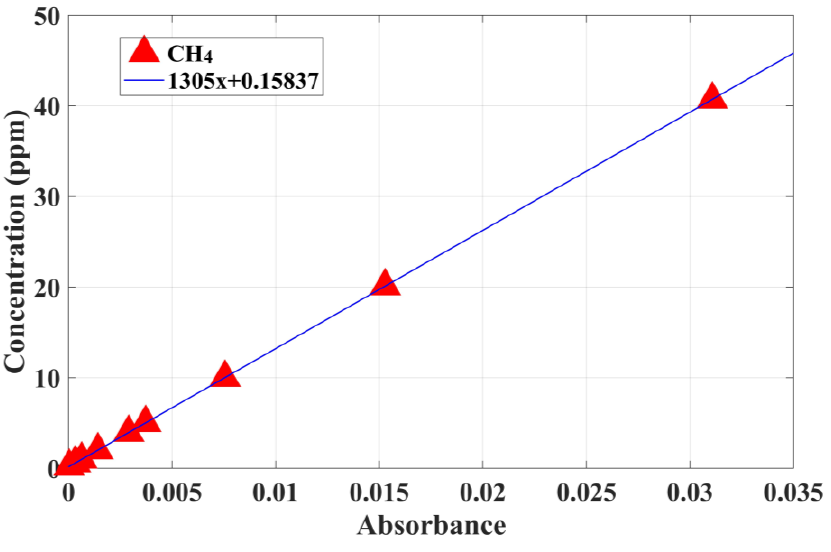
Figure 8. The fitting result in the calibration experiment.